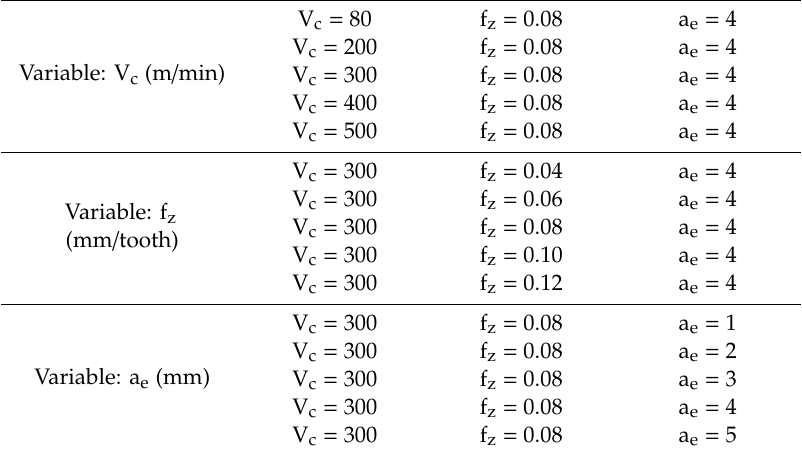
Table 3. Technological parameters of milling.